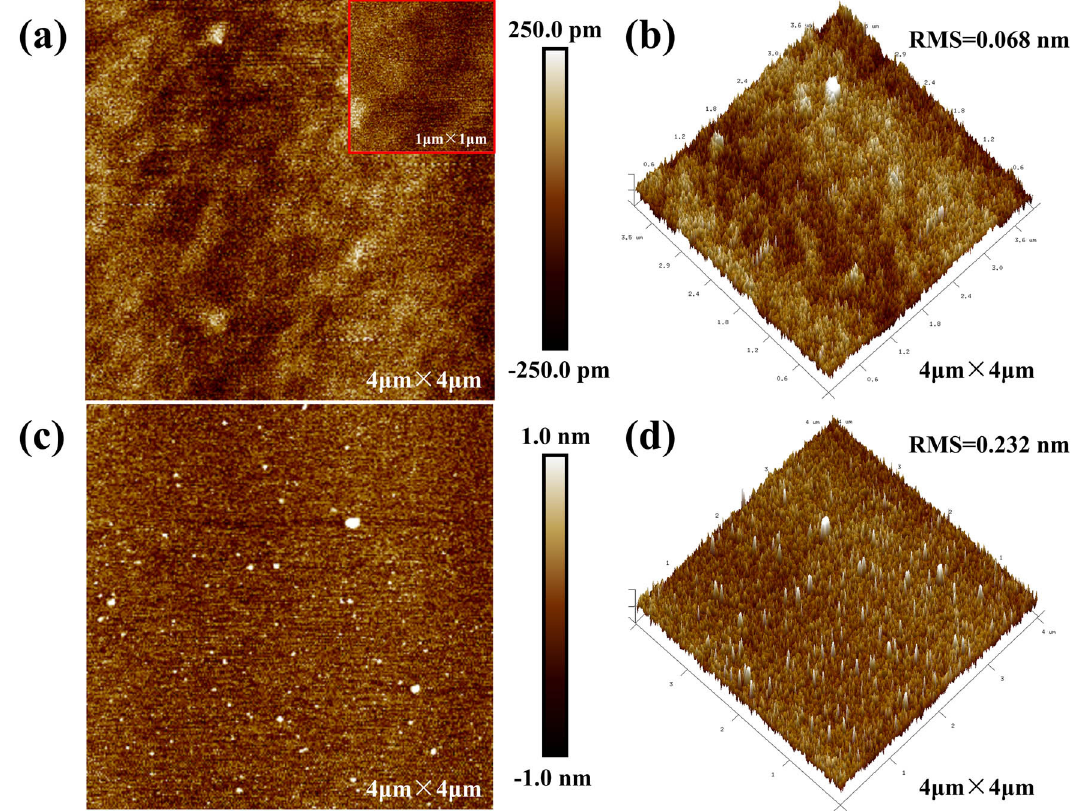
Figure 2: AFM micrographs of the CLD - Al 2 O 3 and the Si substrate. ( a ) 2D and ( b ) 3D AFM images of the CLD - Al 2 O 3 thin fi lm on Si substrate. The inset is an AFM image with much higher magni fi cation. ( c ) 2D and ( d ) 3D AFM images of the bare Si